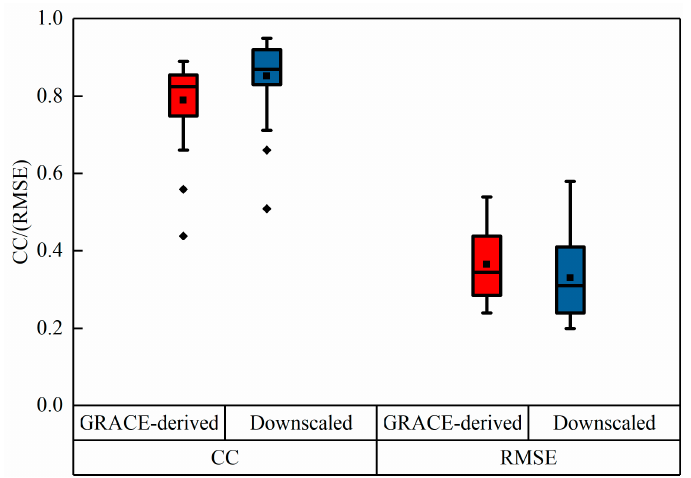
Figure 8. The correlation coefficients and RMSEs from monitoring well GWL observations with corresponding monitoring well locations with downscaled GWSA in the 0.05° grid and GRACE-derived GWSA in the 1° grid after normalization.